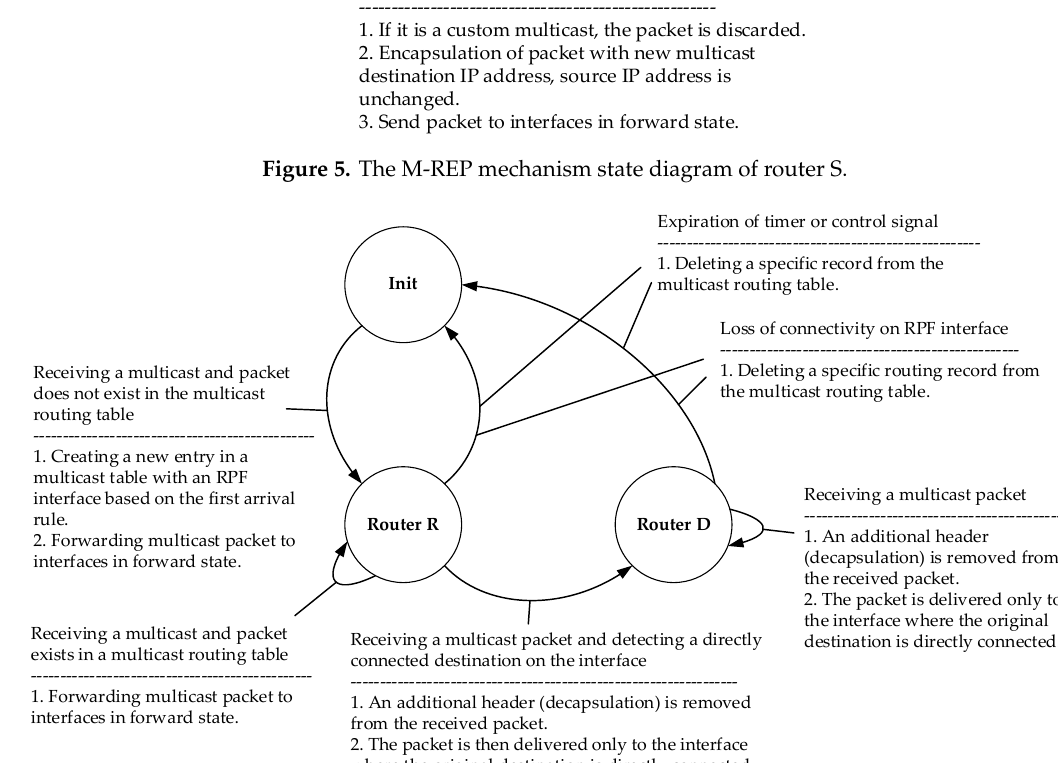
Table 3. States of the M-REP mechanism.